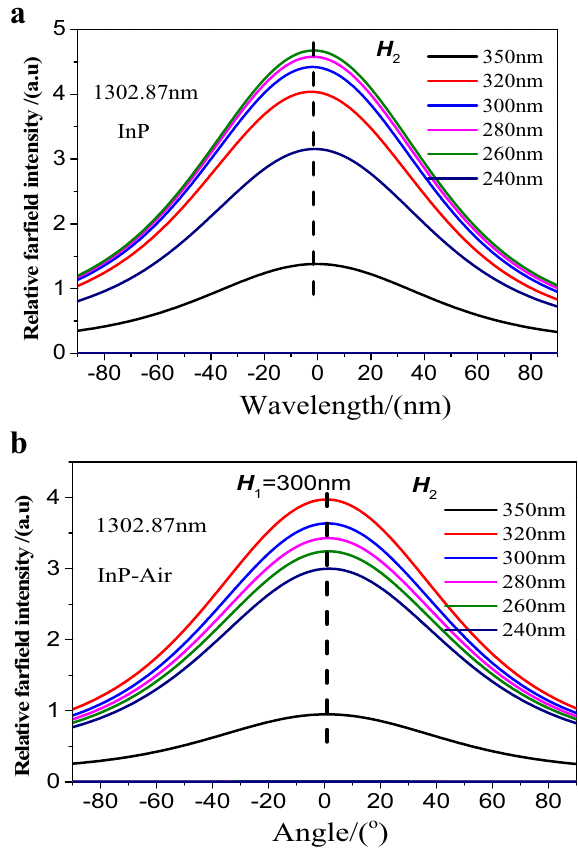
Figure 4. Farfield with vavious angle from − 90° to 90° and changeable height H 2 from 240 to 350 nm before ( a ) and after ( b ) the addition of air cavity under 1302.87 nm